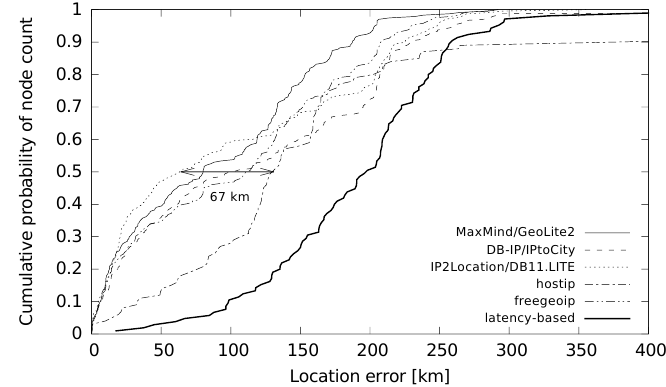
Figure 8. Location accuracy—distance errors for small cities with population p <